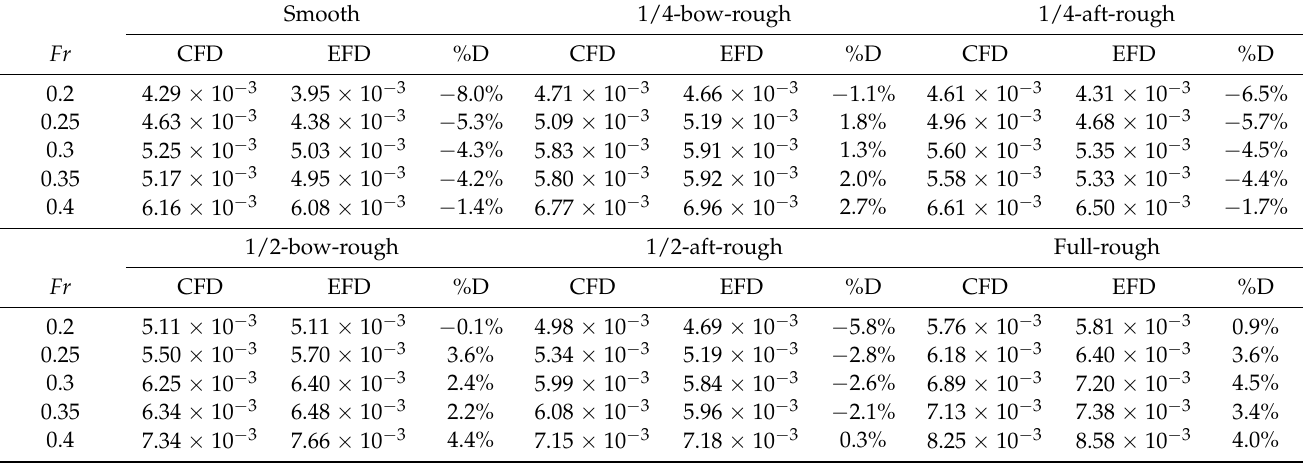
Table A1. Percentage differences between the current CFD simulations and the EFD result